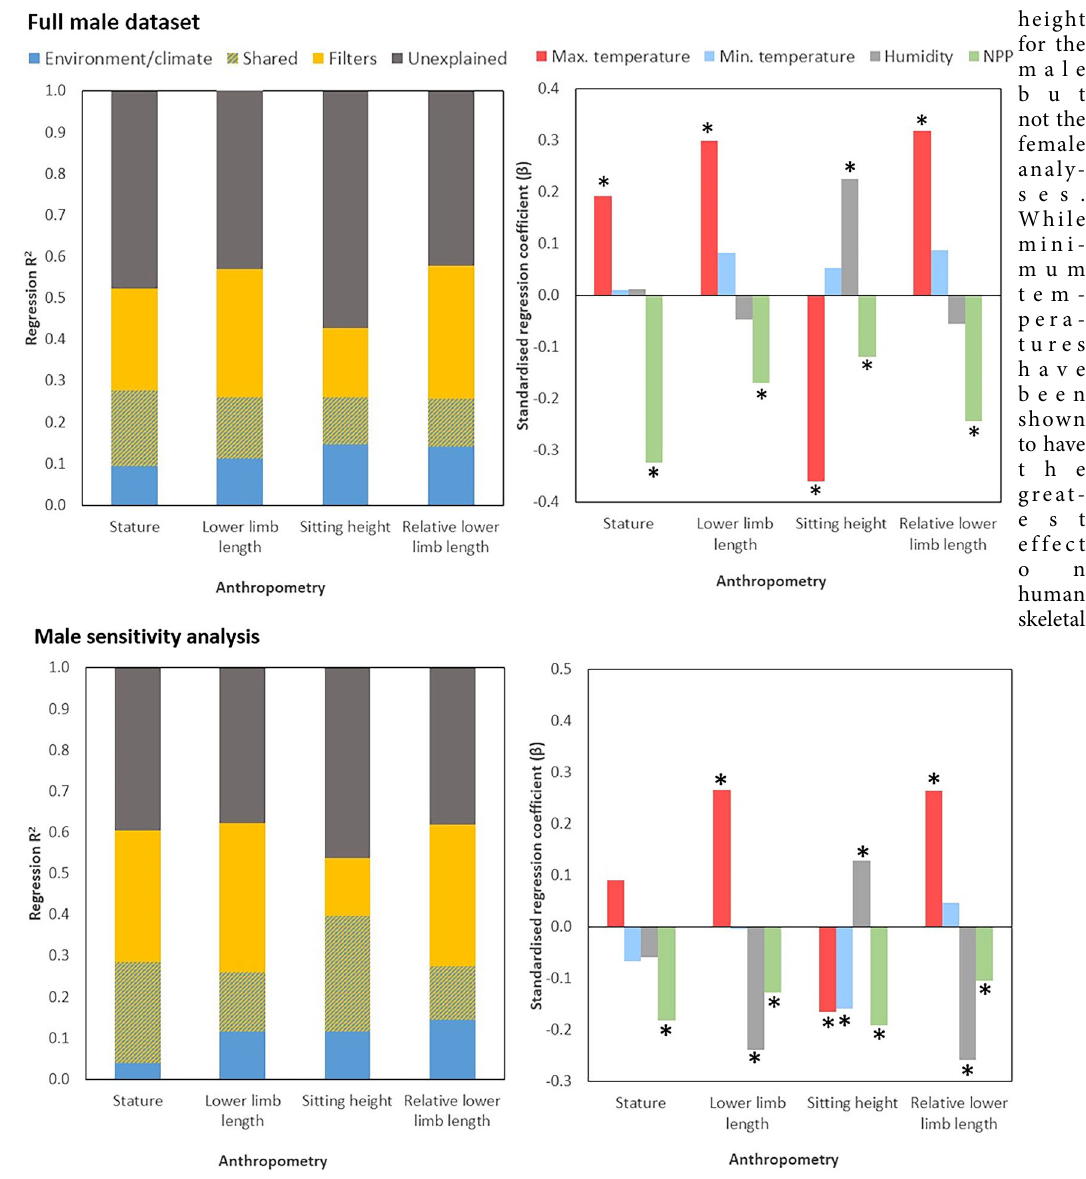
Figure 2. Results from the analysis of relationships between anthropometry and climatic/environmental variables for the male dataset (above: full; below; sensitivity analysis), adjusted for population history using spatial filters. Left: Variation explained by environment/climate, spatial filters, both together, or remaining unexplained by the models. Right: Standardised regression coefficients for environmental/climatic variables in explaining anthropometry, adjusting for population history. NPP net primary productivity. * Denotes p < 0.05 for variable in regression model, of which full details are in Suppplementary Tables S5–S6. Above: full sample. Below: sensitivity